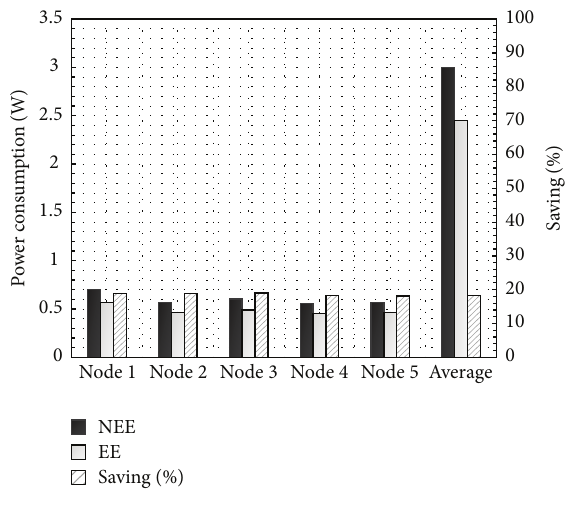
Figure 7: User (VNF) delays with 𝑆 = 5, 𝑁 = 3.